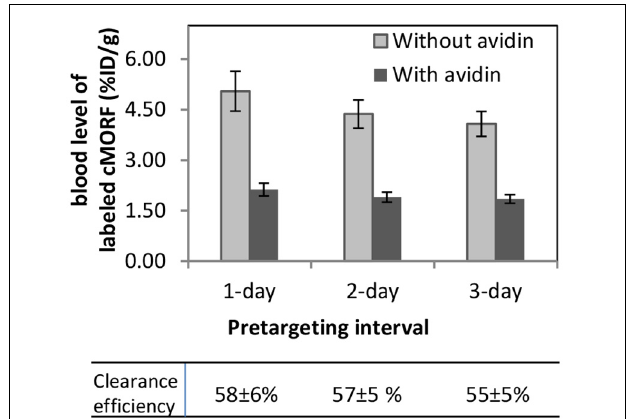
FIGURE 1 | Clearance efficiency at different pretargeting intervals in a pretargeting procedure using biotin-CC49-MORF, avidin, and 99m Tc-cMORF. The cMORF level is proportional to and used as a measure of the antibody level. The clearance efficiency is defined as the ratio of blood level with/without avidin.